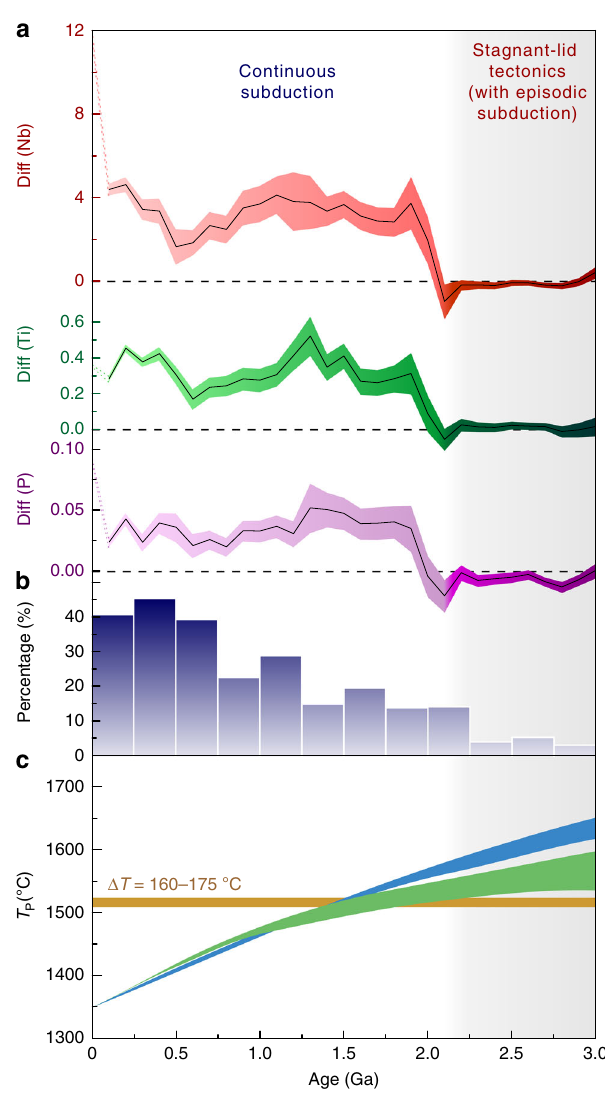
Fig. 4 The evolution of alkali basaltic magmatism throughout Earth ’ s history. a Secular variations of Diff (Nb), Diff (Ti), and Diff (P), respectively, from 3.0 to 0 Ga. The Diff (Nb, Ti or P) is a new geochemical proxy de fi ned in this study to monitor the increase of alkali basaltic rocks. A moving average is applied with the window width equal to 0.5 Ga, while the moving step width is 0.1 Ga. The black solid line in the middle of the three bands from top to bottom are the mean values of Diff (Nb), Diff (Ti), and Diff (P), respectively. The red, green, and purple bands denote standard deviation (s. d.) estimated by the Monte Carlo method. All the Diff (Nb), Diff (Ti), and Diff (P) show rapid increases from nearly zero to positive values at ca. 2.1 Ga. The gray area shows the time range (>2.1 Ga) dominated by stagnant-lid tectonics with episodic subduction, while the white area is the stage (2.1-0 Ga) of continuous plate subduction. The enhancement at the last 0.1 Ga is caused by sampling bias. b The proportion (%) of alkali basalts in relation to all ma fi c rocks at 0.25-Ga time intervals from 3.0 to 0 Ga. The alkali basalt is de fi ned by the Rittmann Serial Index ( σ ) for rocks greater than 3.5 62 . σ = (Na 2 O + K 2 O) 2 /(SiO 2 − 43). c Thermal evolutions models of the mantle as estimated by Korenaga 13 . Green and blue shadings correspond to the dehydration stiffening hypothesis (closed-system evolution) and the mantle hydration hypothesis (open-system evolution), respectively. The closed-system and open-system models are both end- member scenarios. The orange horizontal bar at Δ T = 160 – 175 °C (relative to present-day values) shows the threshold of triggering